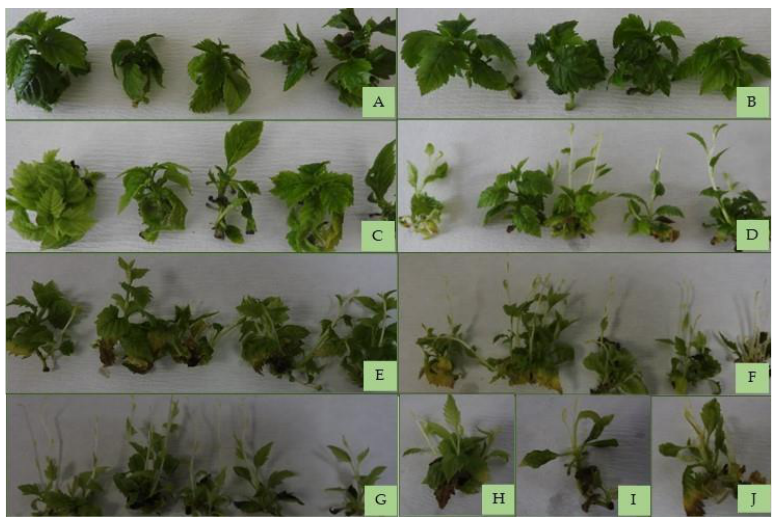
Figure 3. Shoot cultures of Sorbus redliana ‘Burokvölgy’ after storage at 4 °CD and darkness for four weeks ( A ), 16 weeks ( B ), 24 weeks ( C ), 36 weeks ( D ), 40 weeks ( E ), 44 weeks ( F ), 48 weeks ( G ), and 52 weeks ( H , I , J ).